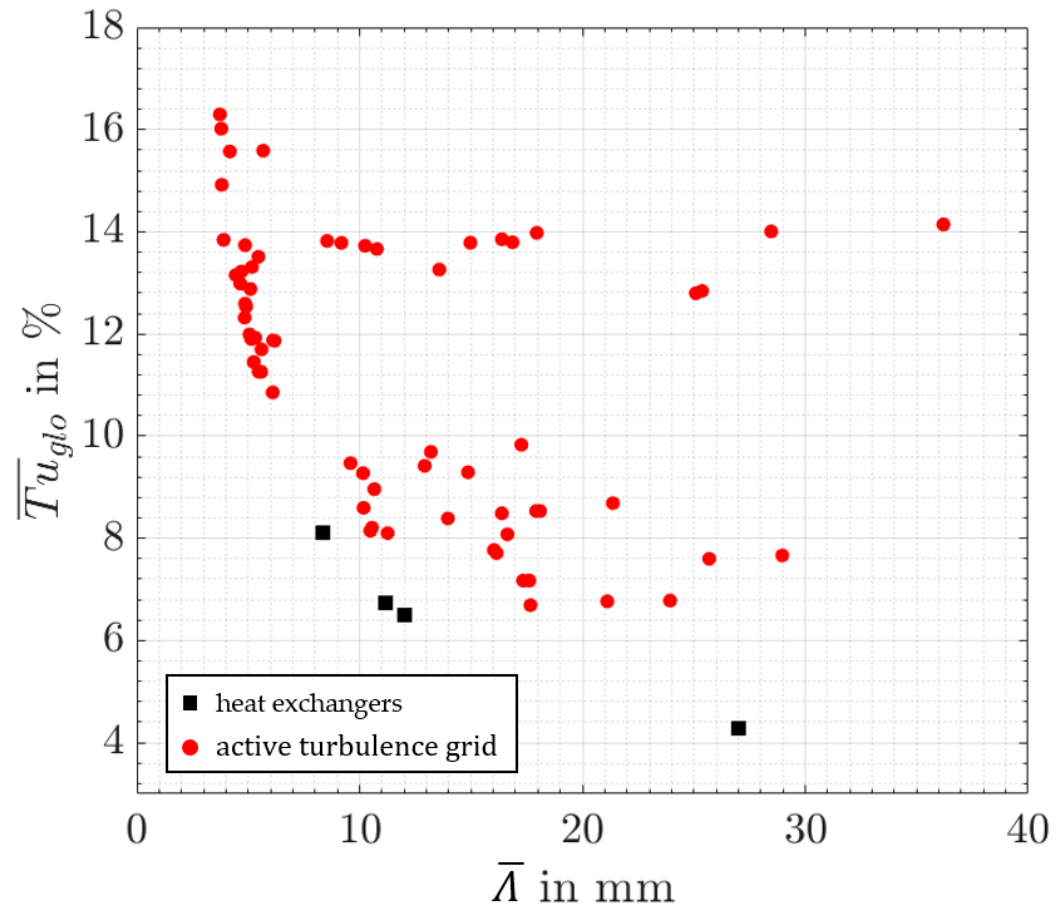
Figure 10. Characteristic map of the induced turbulence characteristics of heat exchangers and different active turbulence grid modes. Black squares are measured values of the heat exchangers, red circles are individual operating modes of the ATG.